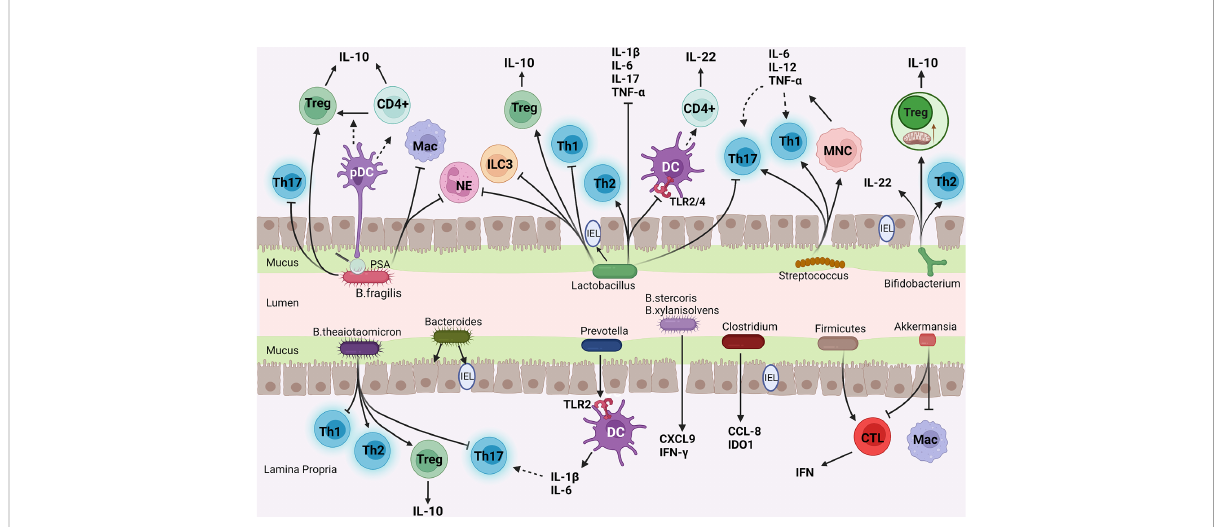
FIGURE 2 The mechanism of common gut bacteria in colon affecting IMC. (I) Bi fi dobacterium enhances Treg cells function and mitochondrial activity; (II) Bacteroides and Lactobacillus inhibit pro-in fl ammatory cells (Th1, Th17 cells, and neutrophils) and enhance anti-in fl ammatory pathways (Treg, Th2 cells differentiation, and IL-10 secretion); (III) Streptococcus promotes monocytes to produce Th1 and Th17 cells polarization factors; (IV) Prevotella stimulated Th17 cells by DC; (v) Akkermansia reduce the number of CTLs and